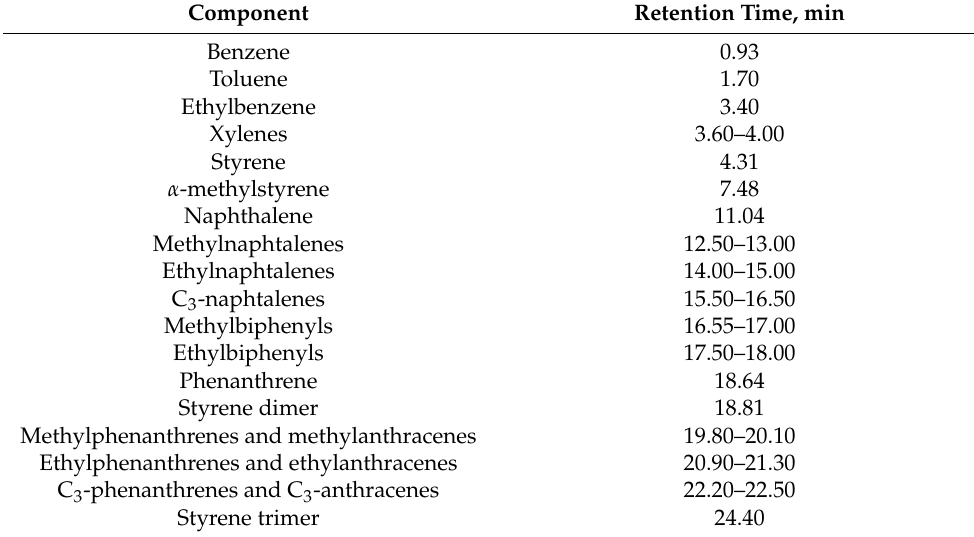
Table 6. The liquid product distribution for the PS conversion in LCO and HCO at 550 °C and WHSV 85 h −1 .